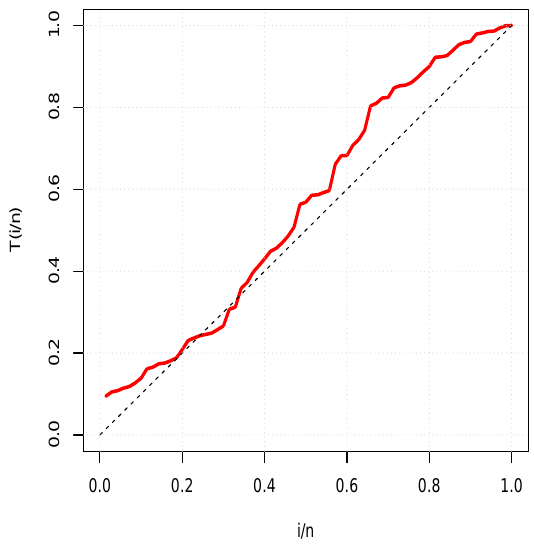
Figure 3. Total time on test (TTT) plot of the COVID-19